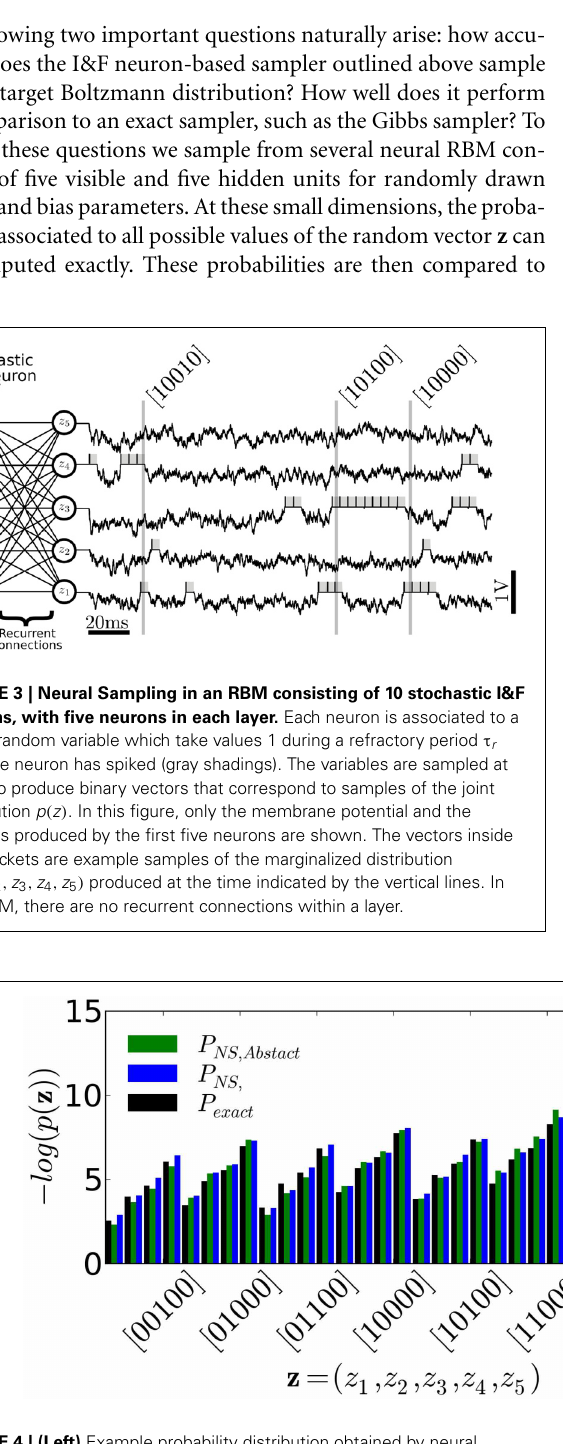
( P Gibbs ), which is the common choice for RBMs. For comparison with the neural sampler, we identified the duration of one Gibbs sampling iteration with one refractory period τ r = 4ms. The plot shows that up to 10 4 ms, the two methods are comparable. After this, the KL divergence of the neural sampler tends to a plateau due to the fact that neural sampling with our I&F neural network is approximate. In both figures, P NS,Abstract refers to the marginal probability distribution obtained by using the abstract neuron model Equation (1). In this case, the KL divergence is not significantly different from the one obtained with the I&F neuron model-based